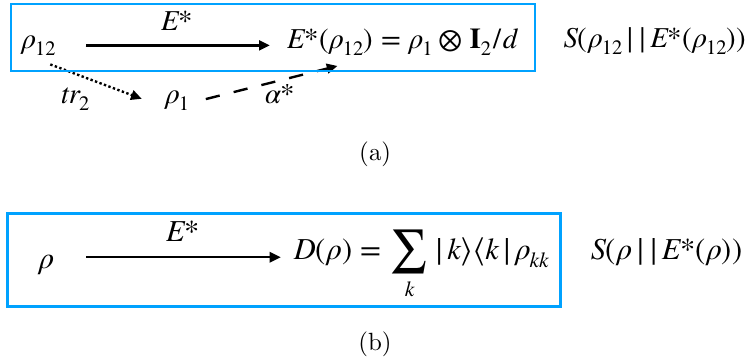
Figure 3. Our entanglement measure is the relative entropy of the state (cid:26) with respect to its corre- sponding invariant state E (cid:3) ( (cid:26) ): S ( (cid:26) k E (cid:3) ( (cid:26) )). (a) The example where the map E (cid:3) is a composition of partial trace of system 2 and the recovery map (cid:11) (cid:3) which results in an invariant state E (cid:3) ( (cid:26) 12